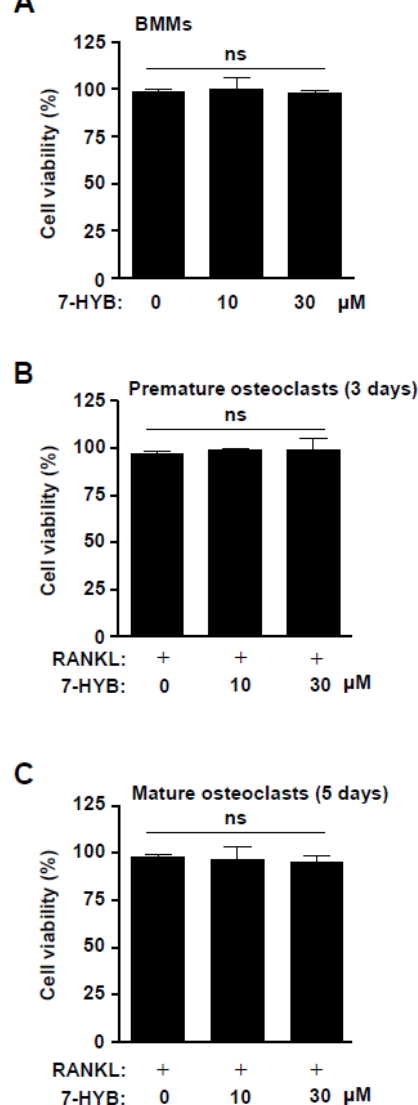
Figure 6. Effect of 7-HYB on the cytotoxicity of osteoclast lineages. ( A ) Bone marrow macrophages (BMMs) were treated with 7-HYB (10 and 30 μM) for 24 h. ( B , C ) BMMs were differentiated into osteoclasts with RANKL (100 ng/mL) in the absence and presence of 7-HYB (10 and 30 μM) for three days ( B ) and five days ( C ). Cell viability was measured using the MTT assay. Data represent the mean ± S.E.M. of experiments. ns: no significant difference when compared to the control.